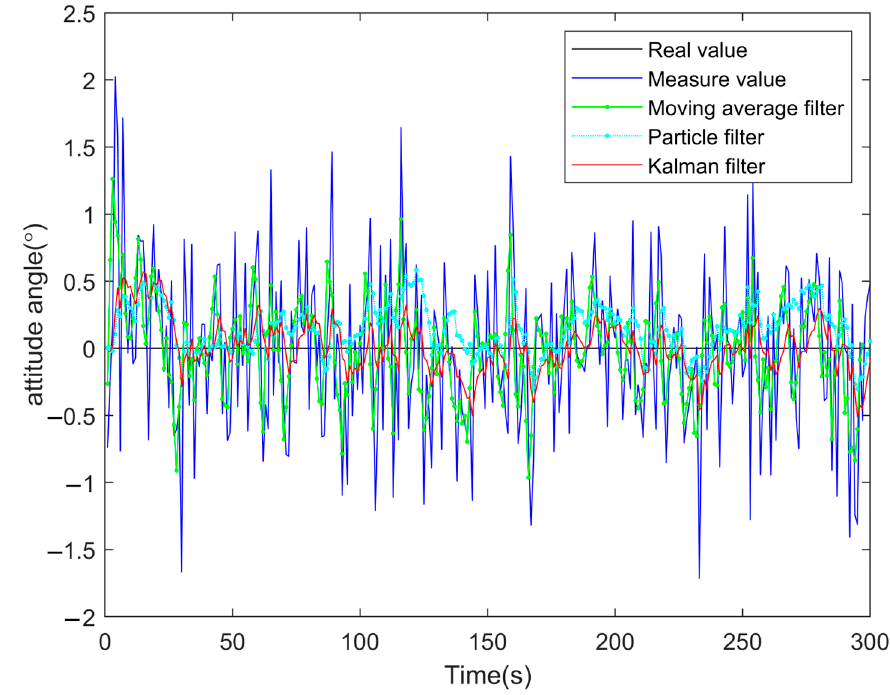
Figure 6. Simulation of the attitude angle of the sowing monomer.